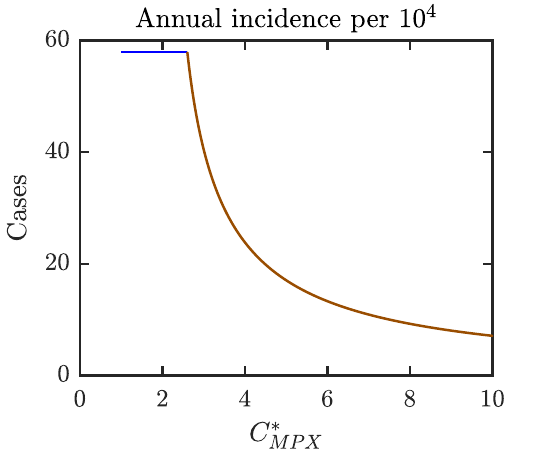
Fig 8. Annual MPX incidence in a population that uses optimal voluntary vaccination rates. The lines are color coded corresponding to the regions shown in Fig 9 which shows a diagram for Nash equilibria as e and C � vary. MPX Blue: 0 is the only NE and it is CSNE. Brown: positive ψ is the only NE and it is CSNE. Unless varied or otherwise NE specified, the parameters are as in Table 1. https://doi.org/10.1371/journal.pntd.0010970.g008 Figs 16–18 illustrate what happens when the transmission rate β increases to 0.18. Without vaccination, the MPX prevalence and annual incidence increase roughly by a factor of 1.5. There is also a backward bifurcation for C � � 2 : 25 . For those values, we have three optimal MPX voluntary vaccination rates. Only 0 and the largest value are CSNE. The medium vaccination rate, ψ is NE but not CSNE. From the public health perspective, it means that there is a NE ,1 need for public policy to mandate the vaccination rate to be at least ψ ; otherwise the NE ,1